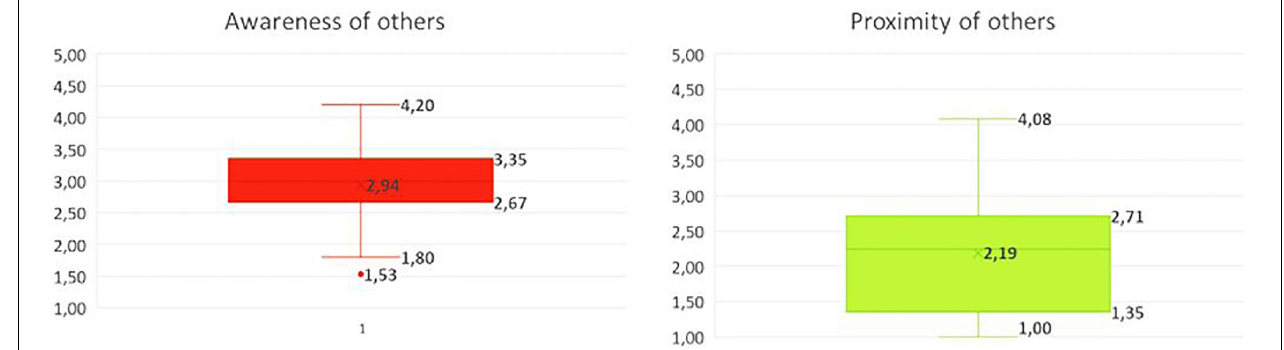
FIGURE 3 | Distribution of mean scores for social presence sub dimensions “awareness of others” and “proximity of others” ( N = 41). All items were scored on a 5-point Likert scale (1 = totally disagree, 5 = totally